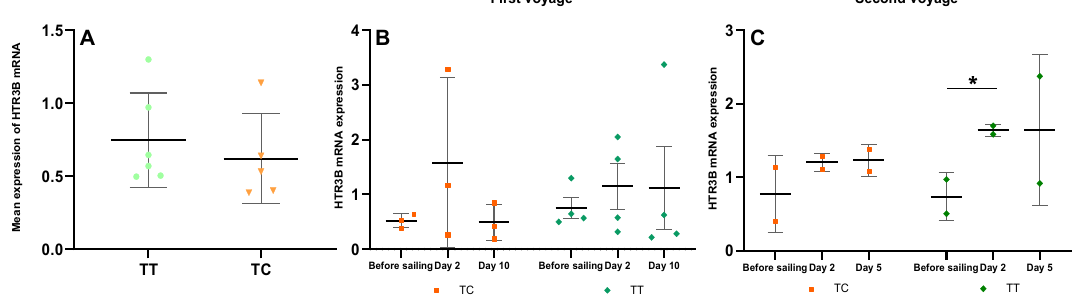
Figure 5. Dynamic changes of HTR3B mRNA level of different rs3758987 genotypes in rs1800544 GG subjects on the two voyages. ( A ) Basic HTR3B mRNA level in different rs3758987 genotype group; ( B ) HTR3B mRNA changes of rs3758987 TC and TT groups on the first voyage; ( C ) HTR3B mRNA changes of rs3758987 TC and TT groups on the second voyage. * p < 0.025; error bar: Standard Deviation (SD).